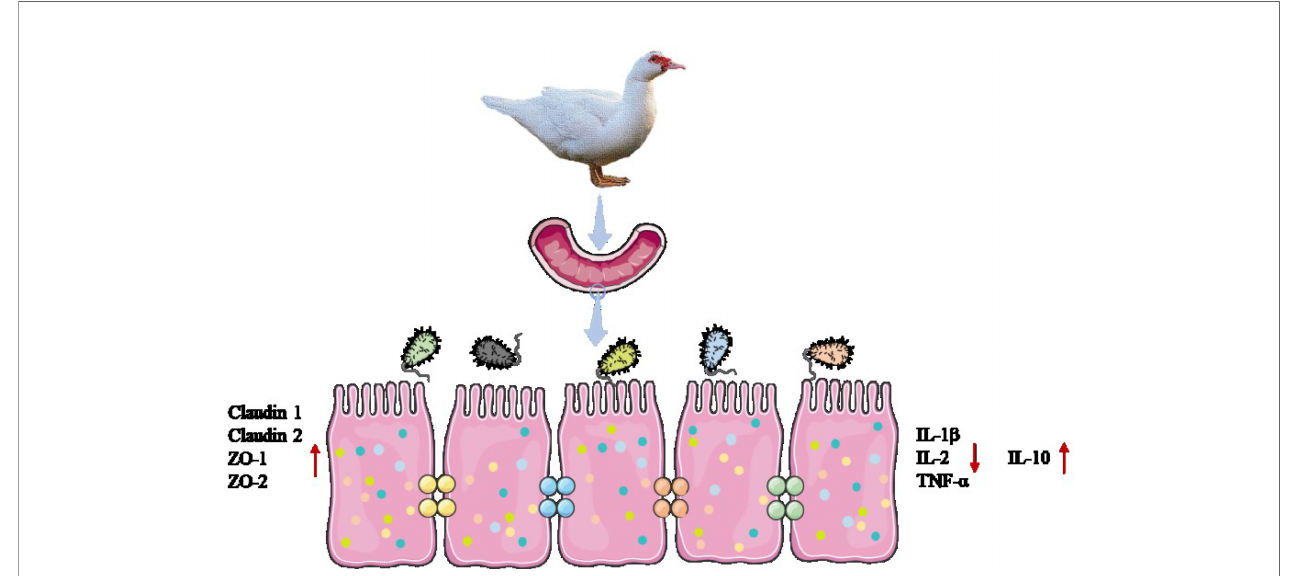
FIGURE 7 | Schematic illustration of ileal microbiota altering immune status to affect body weight in Muscovy